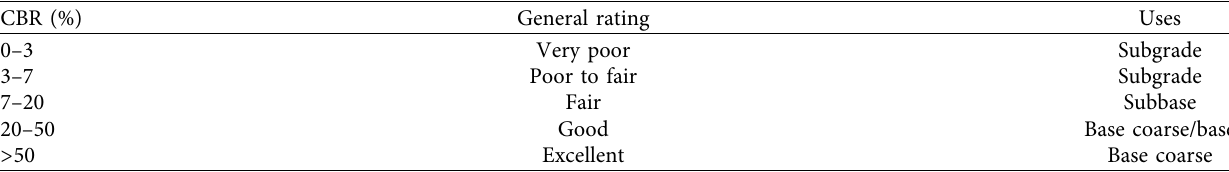
Table 1: ERA manual-2002 rating of subgrade, subbase, and base-course materials based on the CBR value.